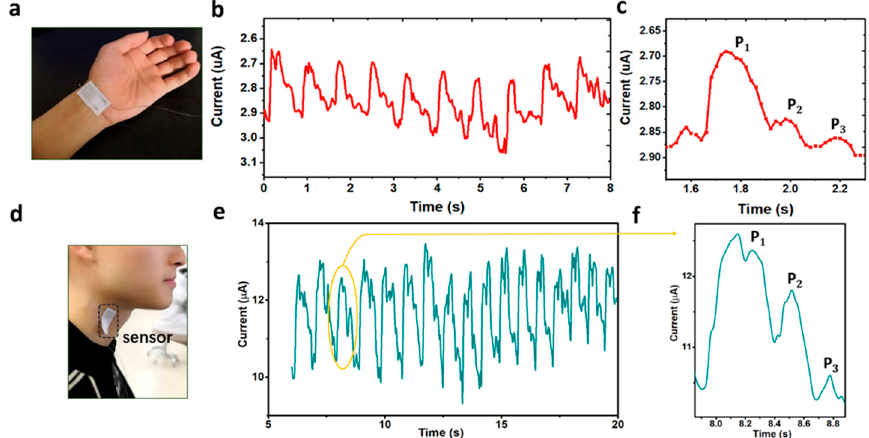
Figure 6. Real-time detection of different physiological signals by using the PANI-based flexible pressure sensor. ( a ) Photograph of a pressure sensor attached on the wrist for wrist pulses detection; ( b , c ) Wrist pulse waveform of the test pressure sensor and one single-pulse waveform; ( d ) Optical image of our textile sensor attached on the neck for arterial pulse waves detection ( e , f ) Neck pulse waveform of the test pressure sensor and one single-pulse waveform.